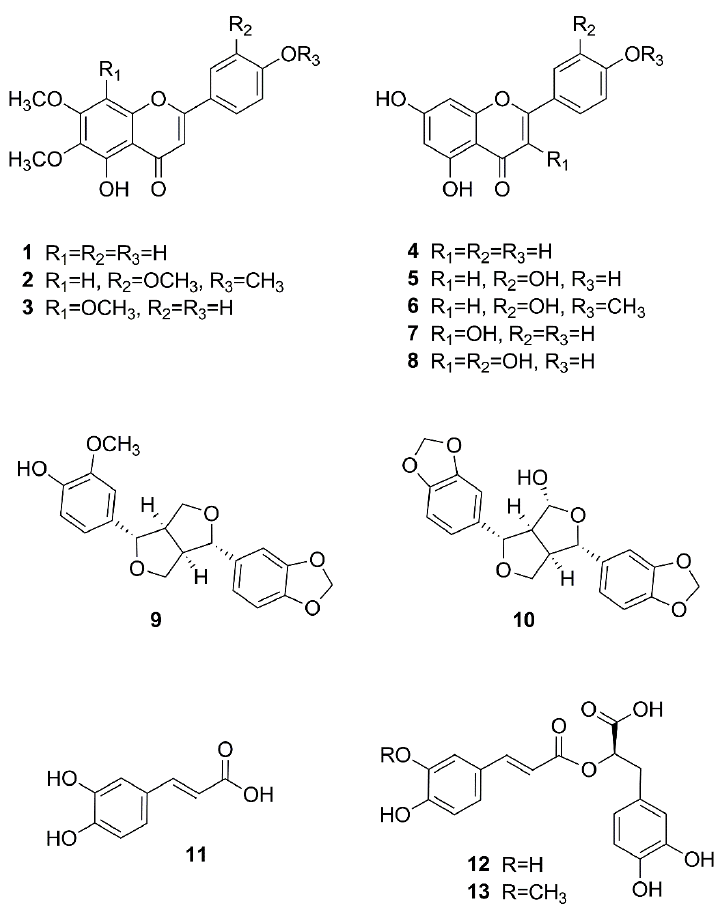
Figure 1. Chemical structures of compounds isolated from D. moldavica .